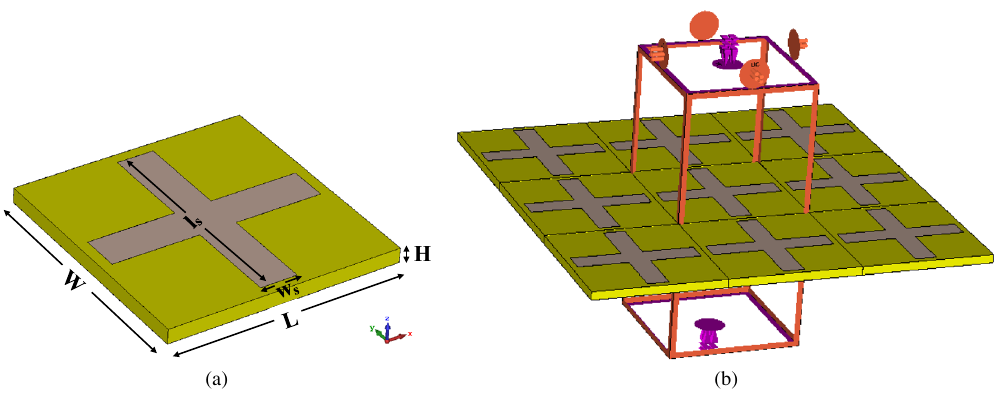
Figure 1. ( a ) Cavity resonator MPA unit cell , ( b ) Numerical setup to analyse MPA